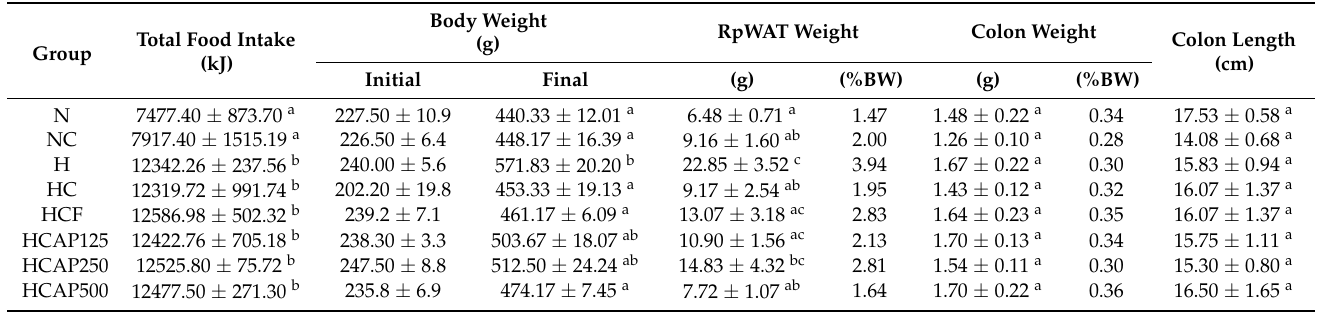
Table 2. Impact of A. paniculata ethanolic extract on food intake, body weight, RpWAT, and colon weight and colon length.